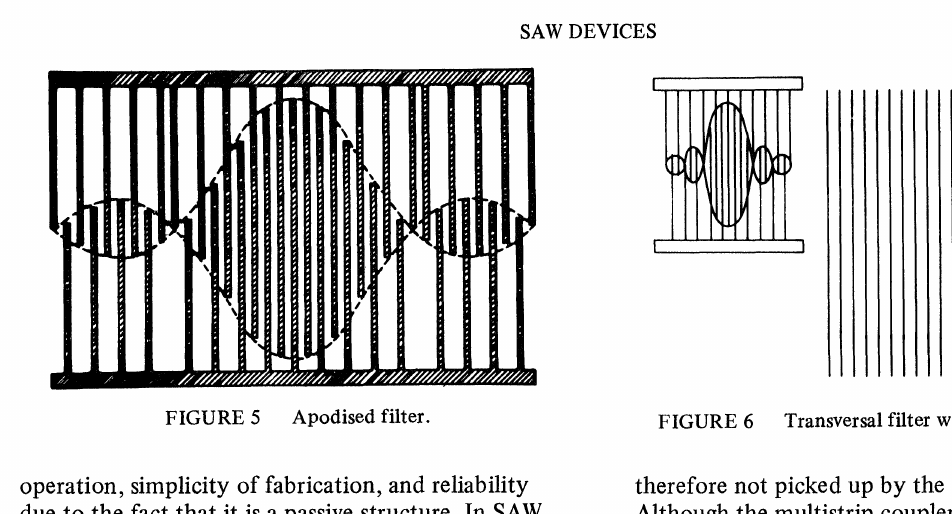
FIGURE 5 Apodised filter. FIGURE 6 Transversal filter with multistrip coupler.